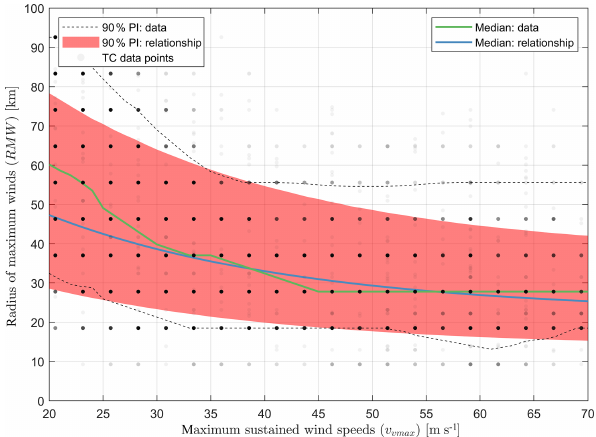
Figure 4. Scatter plot describing RMW (BTD and computed; y axis) as function of the maximum sustained wind speeds ( x axis; and the latitude; not shown). The blue line is the median of the pro- posed relationship derived for all basins at an arbitrarily chosen lat- itude of 10 ◦ . The green line is the median of the BTD. The red area shows the 90% prediction interval (PI) based on the proposed rela- tionship for all basins. The 5% and 95% exceedance values from the BTD are presented as black dashed lines. The gray dots are ob- servation points in which more frequent observations are shown as darker points and less frequent observations as lighter points.